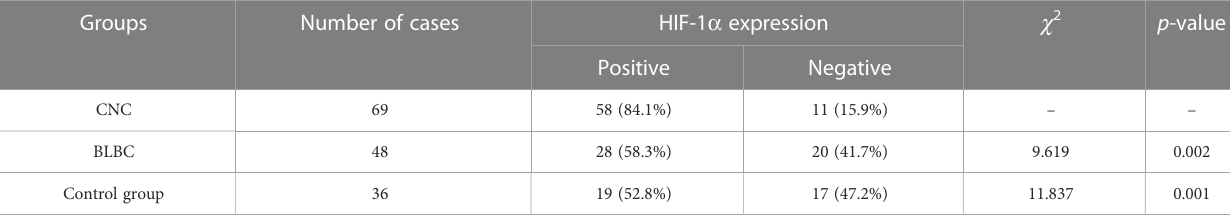
TABLE 4 Comparison of HIF-1 a expression differences between CNC and BLBC and CNC and control